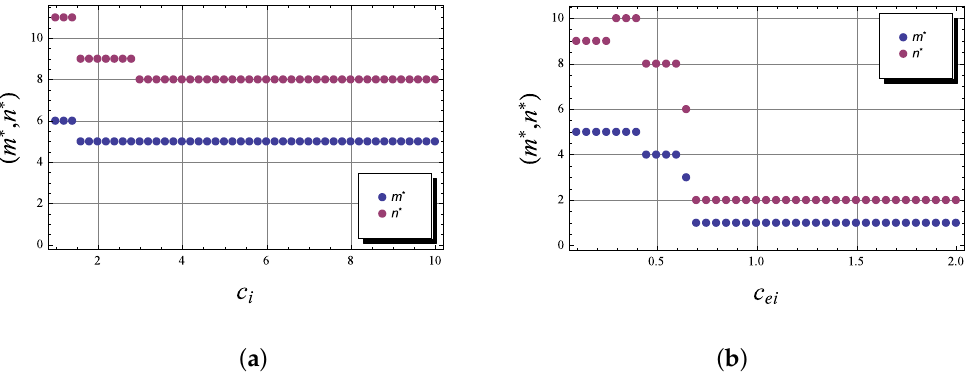
Figure 8. ( m ∗ , n ∗ ) versus c i ( a ) and c ei ( b ) for the model with a preventive